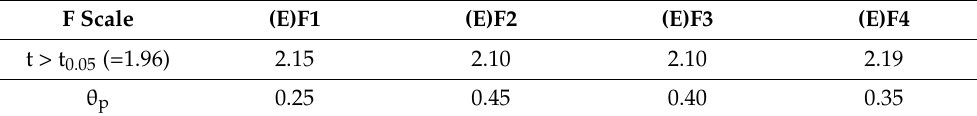
Table 3. T test for mean differences between original and SGR perturbed tornado time series. F Scale t > t 0.05